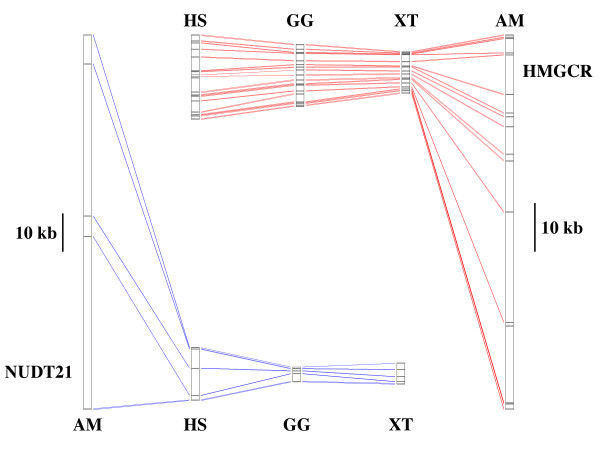
Comparison of intron lengths among the axolotl (AM), human (HS), chicken (GG), and frog Xenopus tropicalis (XT) for cleavage and polyadenylation specific factor 5 (NUDT21) and 3-hydroxy-3-methylglutaryl-Coenzyme A reductase (HMGCR). One exon of HMGCR could not be identified in the X tropicalis genome.